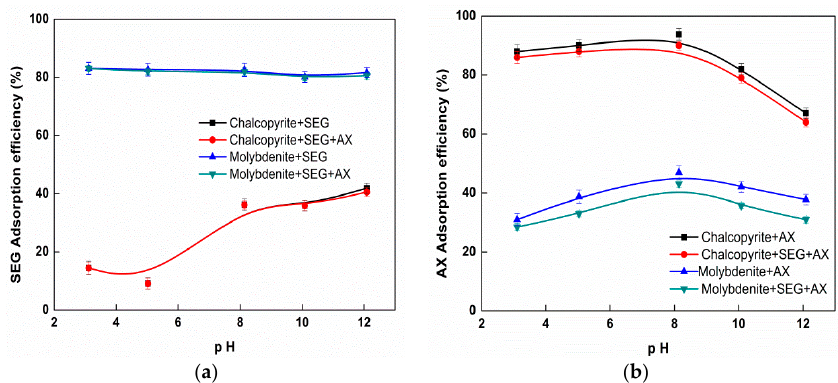
Figure 7. The adsorption efficiency of ( a ) SEG and ( b ) AX on single mineral surfaces as a function of pH (SEG: 197 mg/L, AX: 16 mg/L).